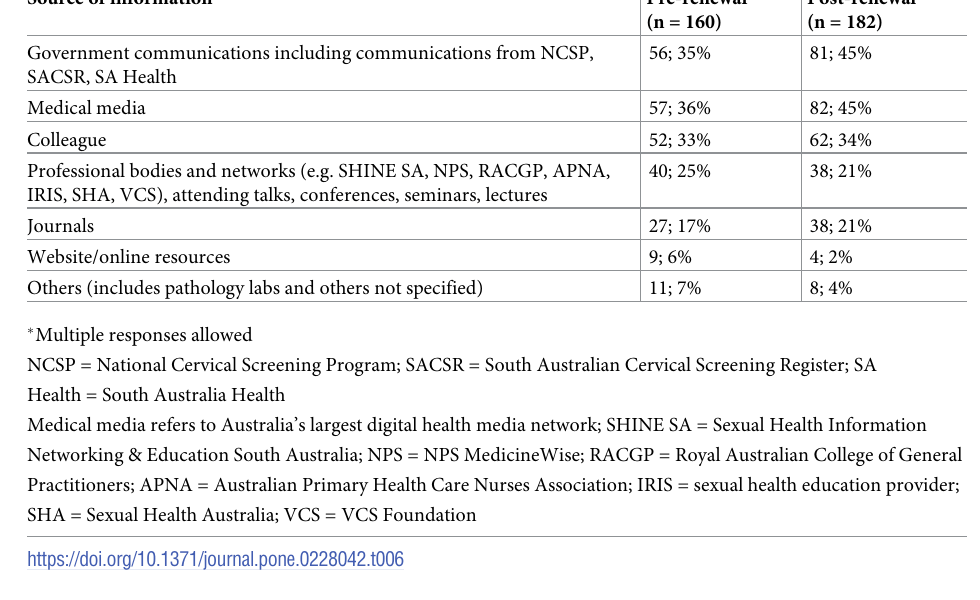
Post-renewal (n = 160) (n =